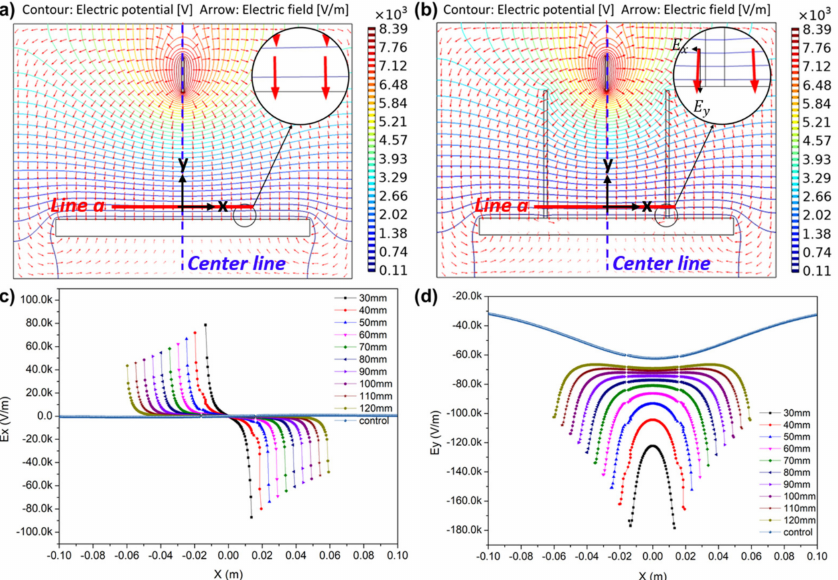
Figure 4. ( a , b ) Simulated electric potential (contour in figure) and electric field (arrow in figure) distribution during electrospinning ( a ) without and ( b ) with a cylindrical dielectric guide and ( c , d ) electric field strength ( c ) Ex and ( d ) Ey along reference Line a for various cylindrical dielectric guide diameters (Control in Figure 4c,d mean without cylindrical dielectric